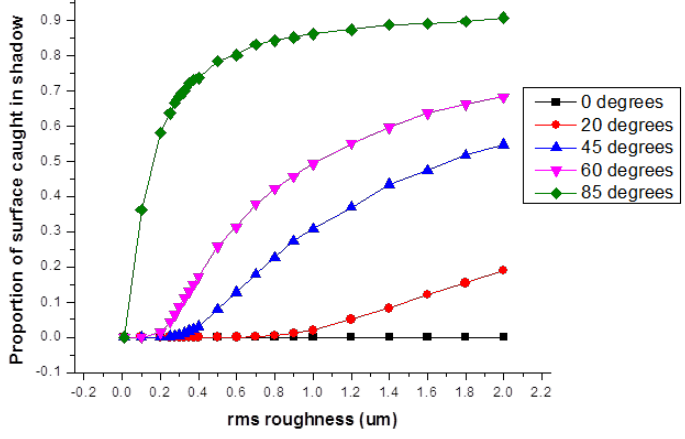
Figure 3. Proportion of surface caught in shadow for a PMMA surface with varying surface roughness and fixed autocorrelation length (1 μm). The 590 nanometer wavelength incident radiation impinges on the surface at incident angles ranging from 0° to 85° relative to the global surface